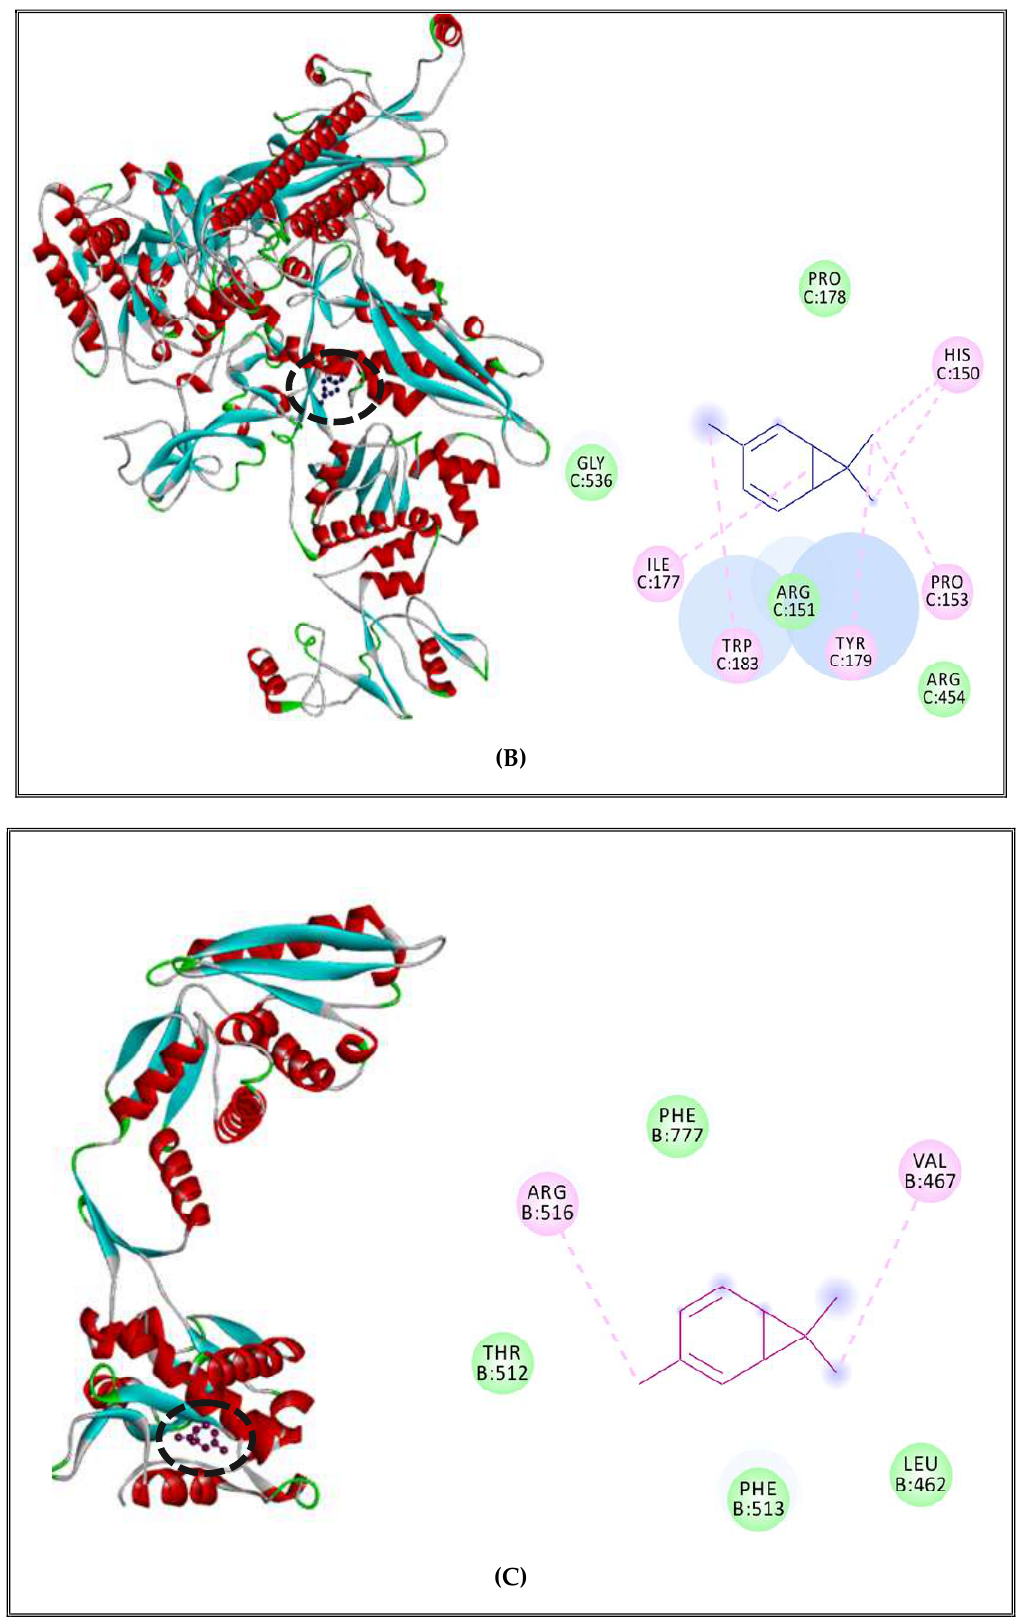
Figure 7. δ-3-carene complexed with DNA polymerase enzyme ( A ), RNA polymerase ( B ), topoisomerase II ( C ) of S. enterica Typhimurium.